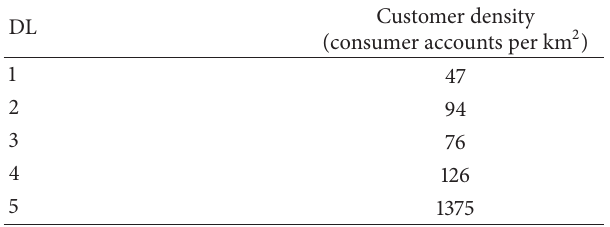
Table 5: Differences in customer densities.